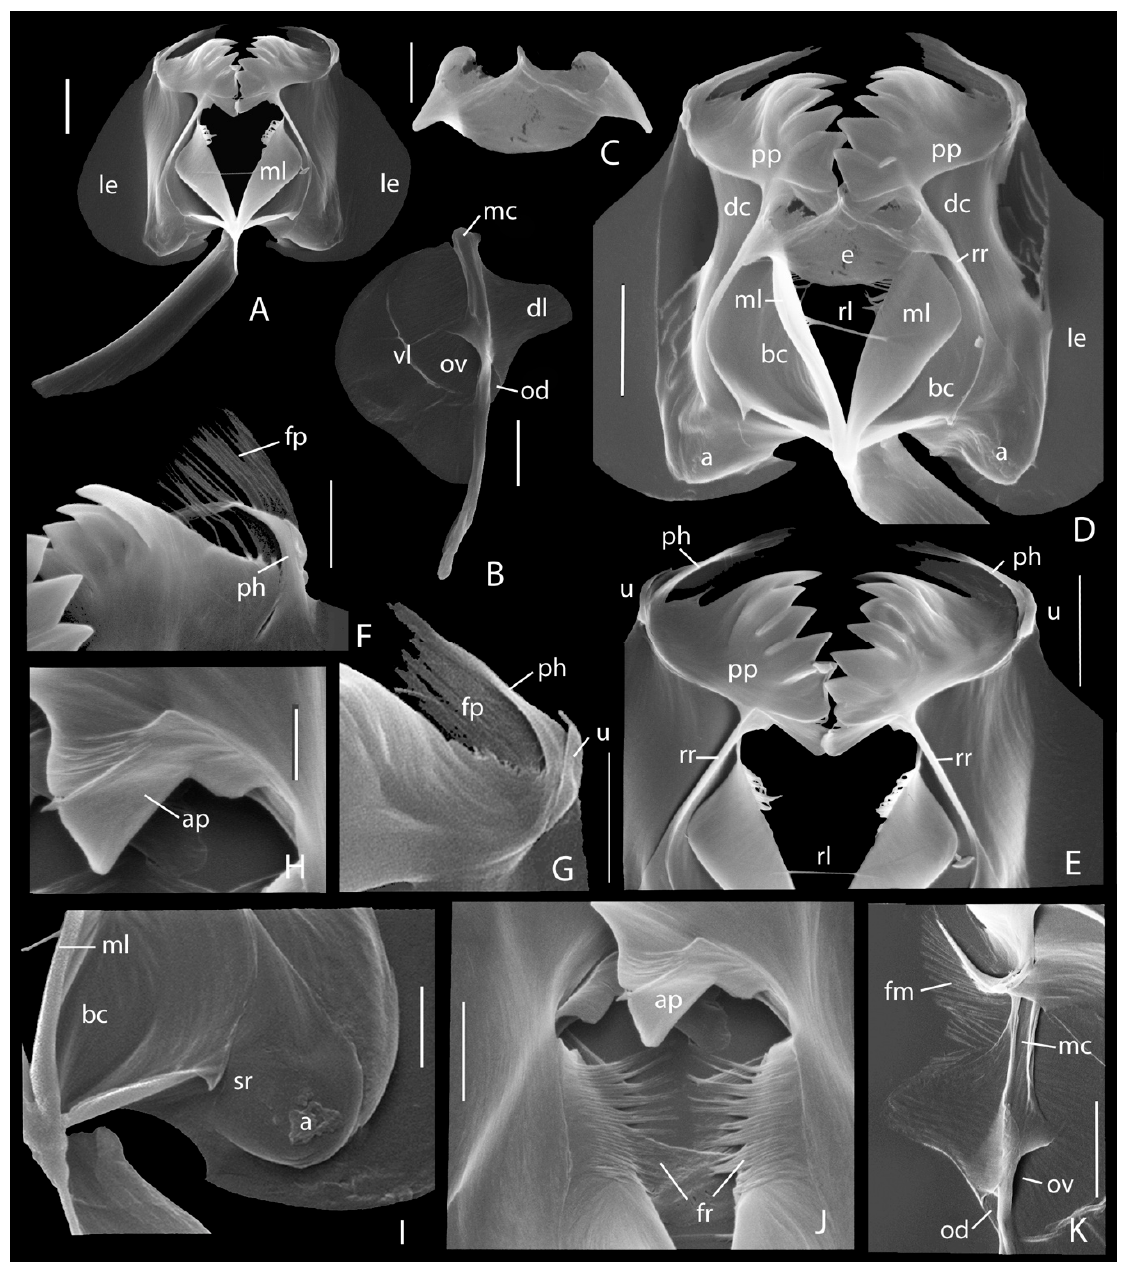
Figure 7. Synchaeta grossa sp. nov., SEM photographs of trophi. ( A ) Incus, ventral. ( B ) Left manubrium, outer view. ( C ) Epipharynx. ( D ) Detail incus, ventral. ( E ) Pseudunci, ventral. ( F ) Detail right pseuduncus, inner view. ( G ) Detail left pseuduncus, outer view. ( H ) Adjoining platelet of pseuduncus plate, inner view. ( I ) Left alula and spinula rami, outer view. ( J ) Fimbriae ramorum, dorsal. ( K ) Fimbriae manubrii, outer view, right. a: alula; ap: adjoining platelet; bc: basal chamber; dc: dorsal chamber; dl: dorsal lamella; e: epipharynx; fm: fimbriae manubrii; fp: fimbriae pseudunci; fr: fimbriae rami; mc: median chamber; ml: median ramus lamella; le: lamellar ramus extension; od: opening dorsal chamber; ov: opening ventral chamber; ph: pseuduncinal hook; pp: pseuduncinal plate; rl: ramus-ramus ligament; rr: ramus ridge; sr: spinula rami; u: uncus; vl: ventral lamella. Scale bars: ( A , B , D , E ): 10 µm; ( C , F , G , I − K ): 5 µm, ( H ): 2.5 µm. Diagnosis: Medium-sized Synchaeta up to 250 µm; body plump, vase-shaped; auricles small to medium; foot medium, stout; ventral sensory pit/caudal antenna at some distance from base of toes;